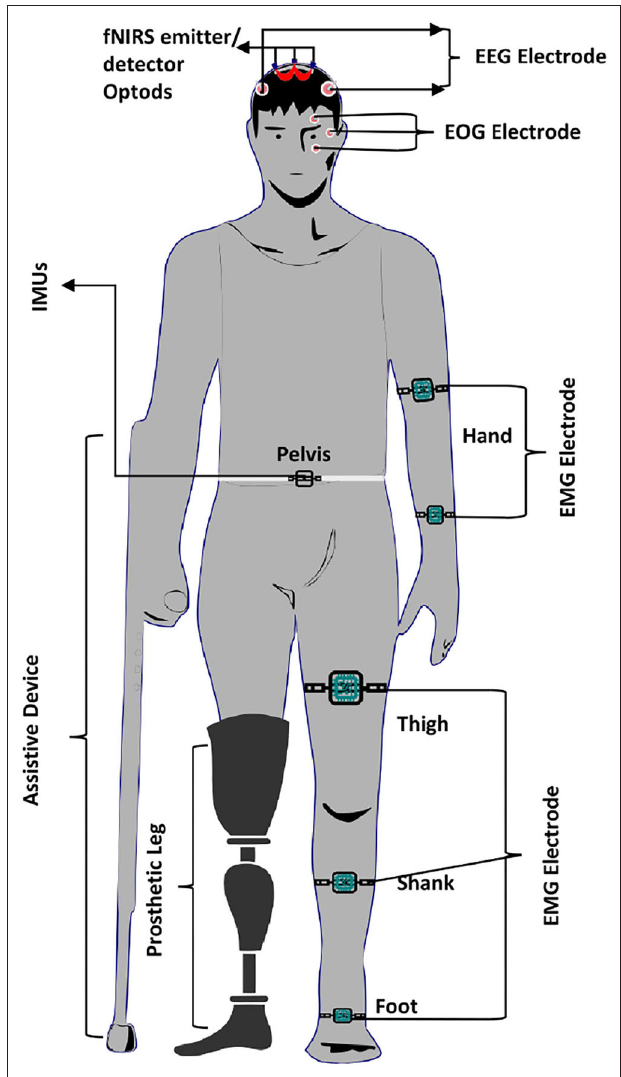
FIGURE 5 | Illustration of bio-sensors placement during gait assessment.